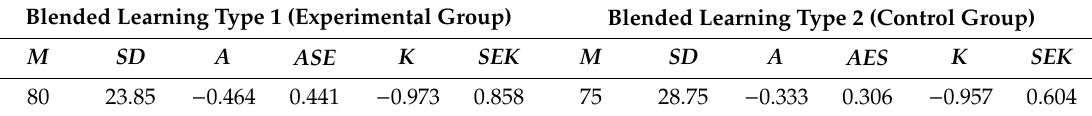
Table 3. Indicators of asymmetry and kurtosis in the experimental group and control